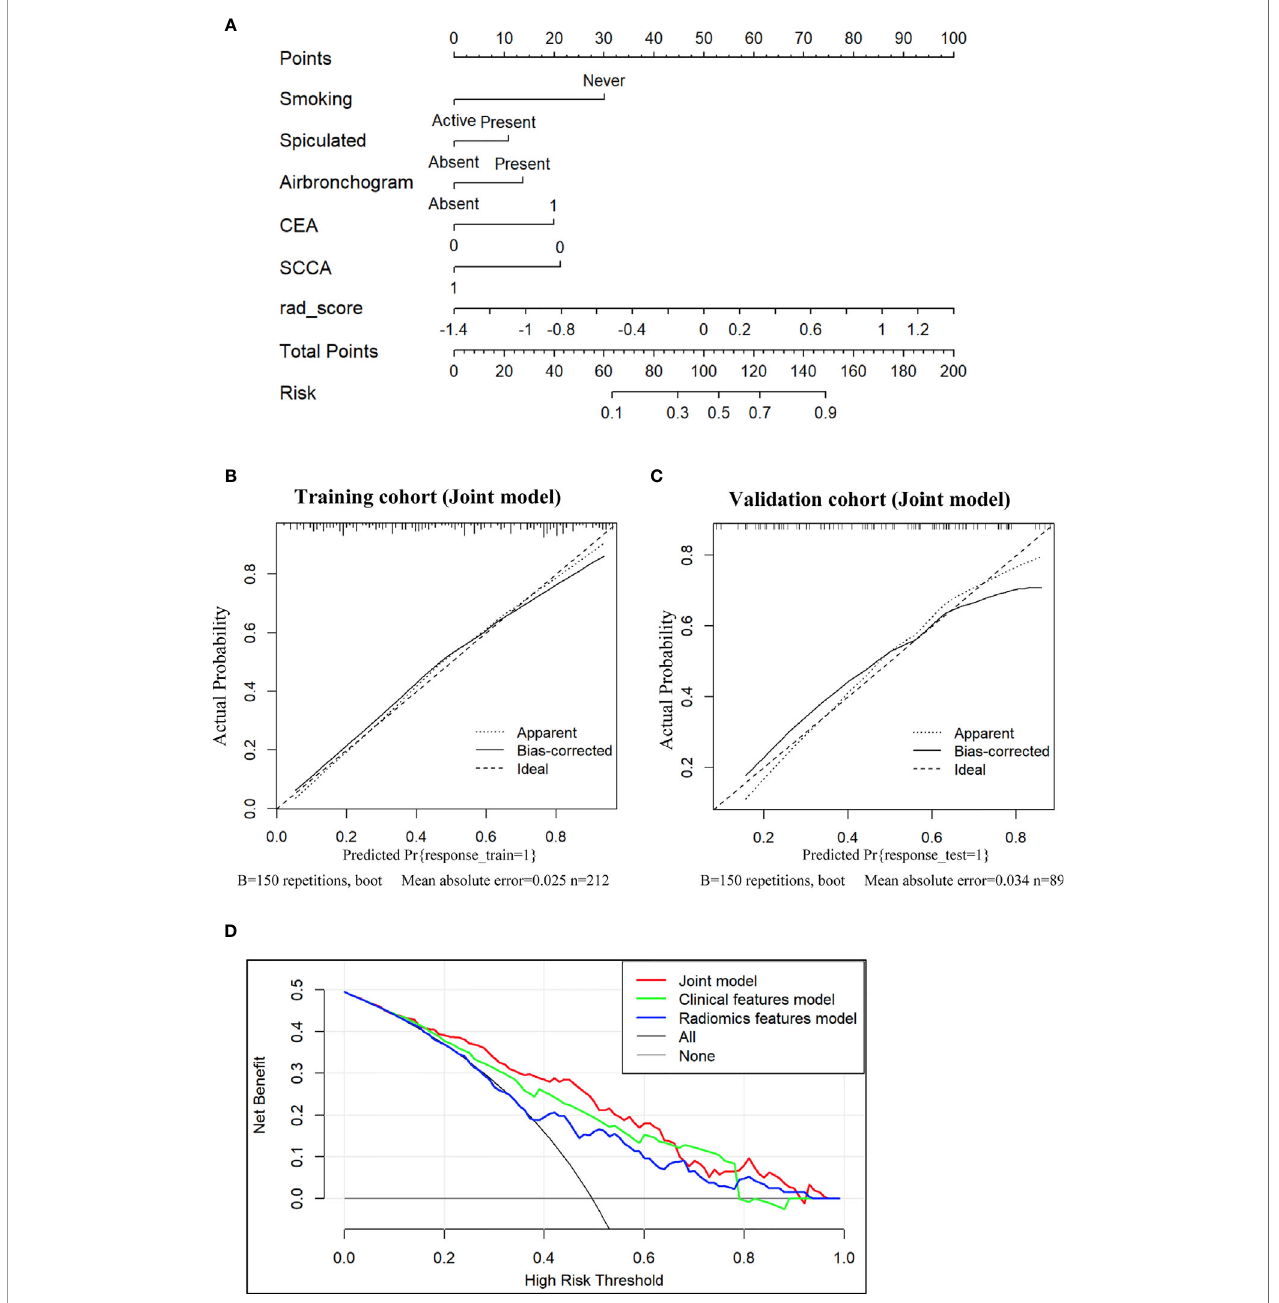
FIGURE 4 | Nomogram for the prediction of EGFR-activating mutations based on the training cohort and the calibration curve for model evaluation. (A) Radiomic nomogram constructed with the clinical characteristics and Radscore. Calibration curves were used to assess the consistency between the nomogram-predicted EGFR-activating mutation probability and the actual fraction of EGFR-activating mutations in both the training (B) and validation (C) cohorts (D) . DCA for the prediction of EGFR-activating mutations in NSCLC patients for each model. The X-axis represents the threshold probability, and the Y-axis represents the net bene fi t. The net bene fi t is calculated by adding the bene fi ts (true-positive results) and subtracting the risks (false-positive results), with the latter weighted by a factor related to the harm of an undetected cancer relative to the harm of unnecessary treatment. The red curve indicates the nomogram, which represents the joint prediction model composed of radiomic features and clinical indicators. The green curve represents the clinical feature model, while the blue curve represents the radiomic feature model. Our joint prediction model outperformed both the other models and simple strategies, such as the follow-up of all patients (grey line) or no patients (horizontal black line), across the majority of the range of threshold probabilities at which a patient would choose to undergo a follow-up imaging